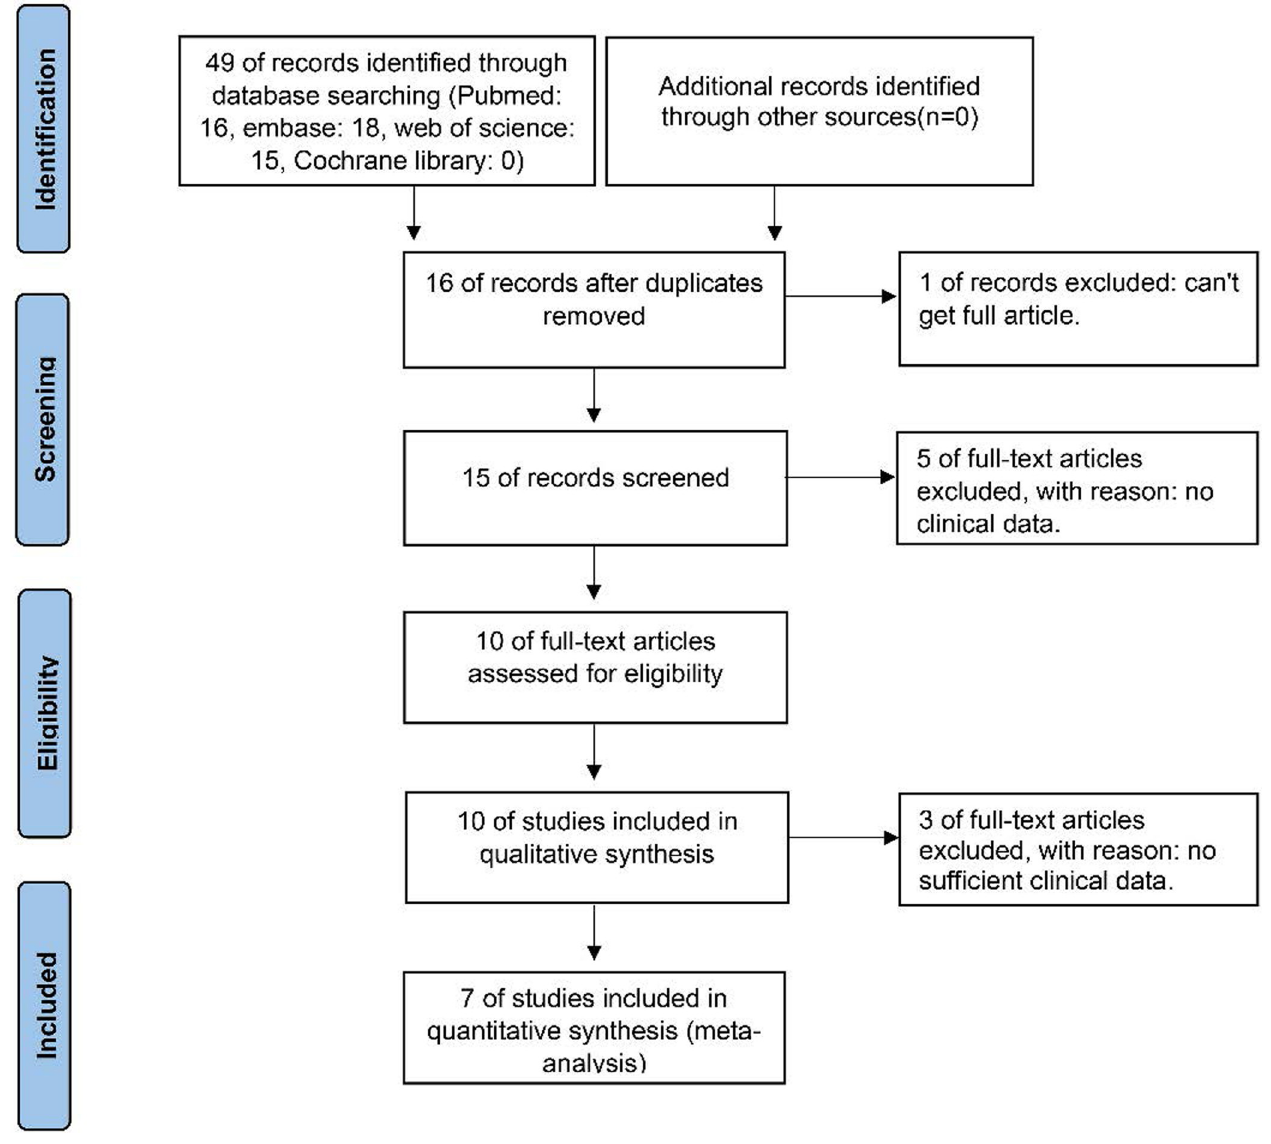
Fig 1. Flow diagram of this